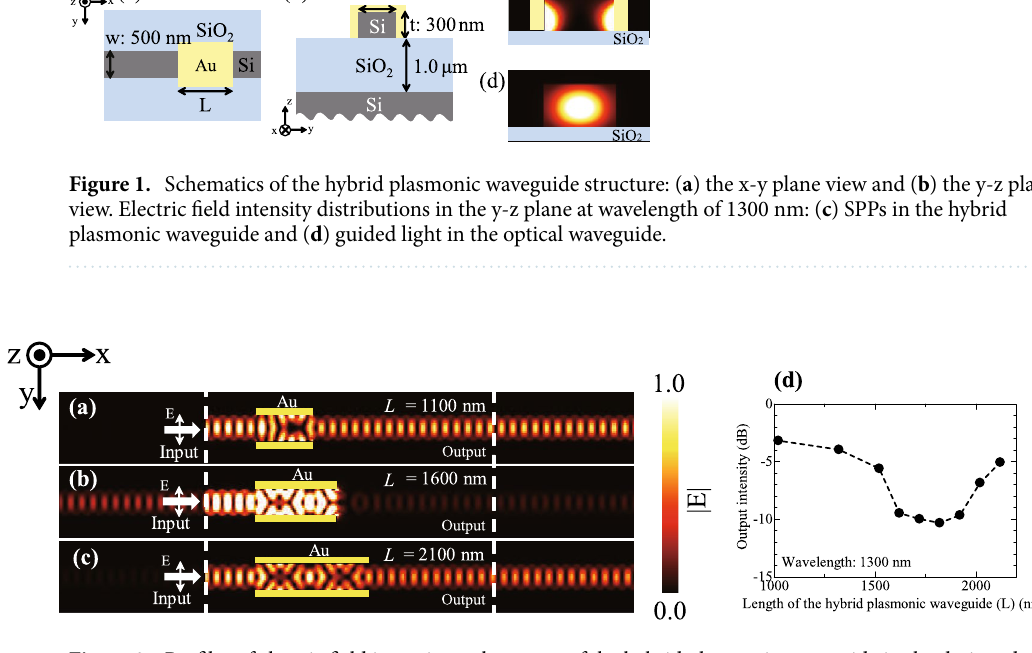
Figure 2. Profiles of electric field intensity at the centre of the hybrid plasmonic waveguide in the designed structure with ( a ) L = 1100 nm, ( b ) L = 1600 nm and ( c ) L = 2100 nm. The incident light wavelength is 1300 nm. The incident light has an electric field component in the y direction. ( d ) Output intensities as functions of L for the designed structure. The wavelength of incident light is 1300